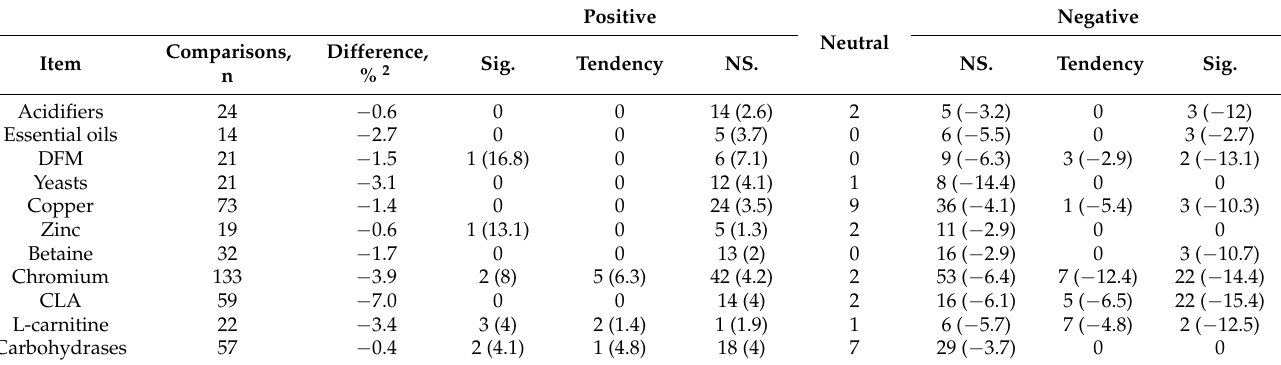
Table 3. Summary of the effects of feed additives on grow–finish pig BF 1,3